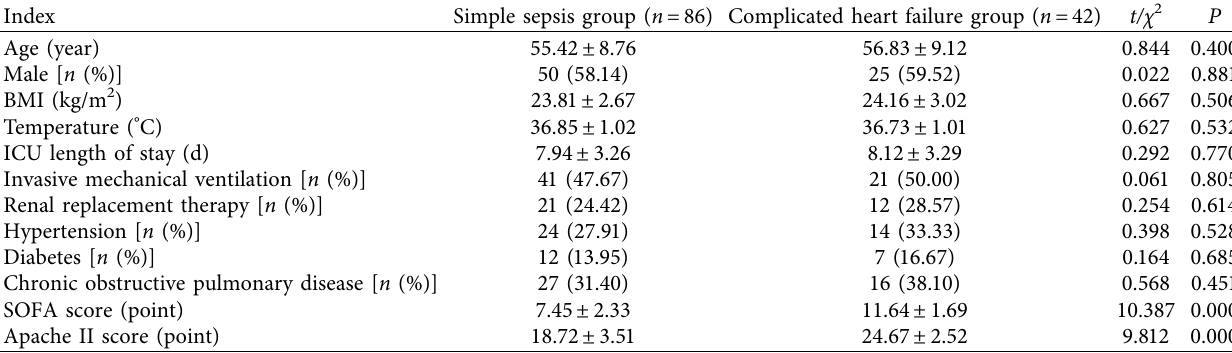
Table 1: Comparison of clinical data between the simple sepsis group and the complicated heart failure group [ ( x ± s ) / n (%)].